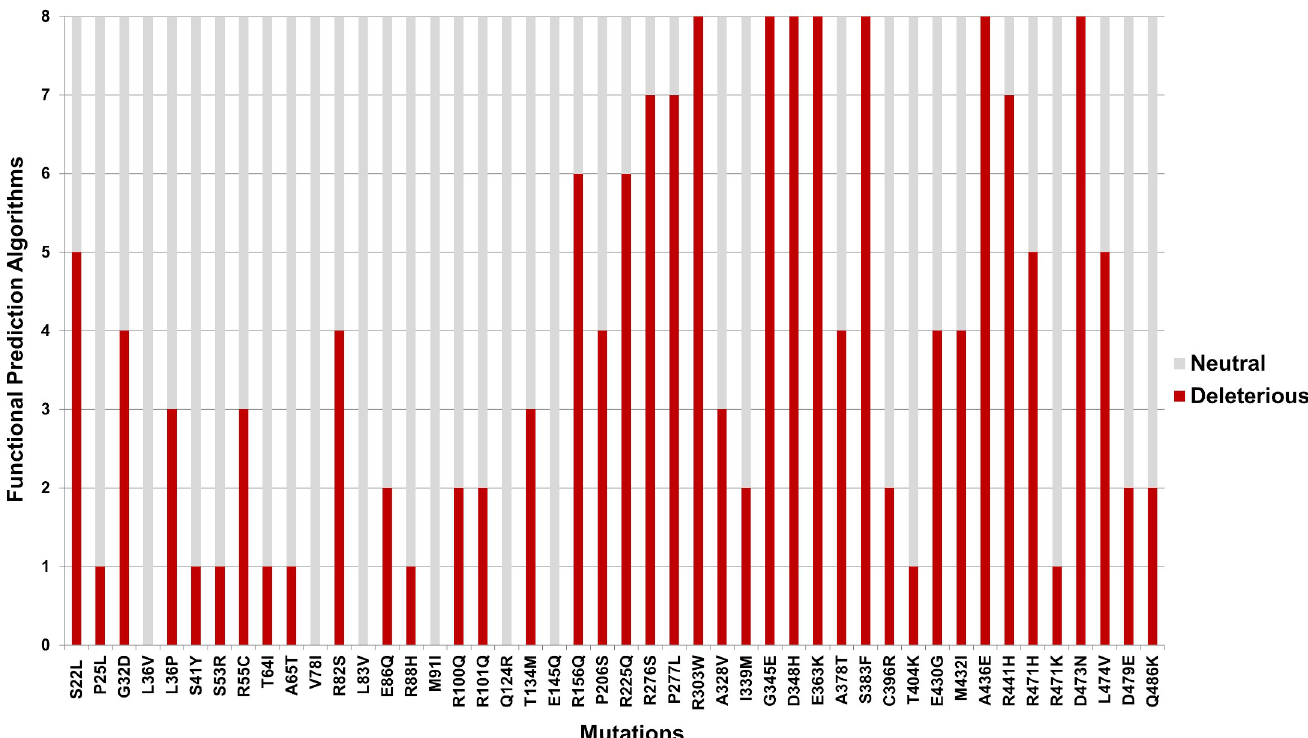
Fig 2. Functional prediction of TPH2 mutations. The 46 known TPH2 mutations were analyzed using eight different functional prediction algorithms. The bar plot indicates the number of neutral (gray bars) and deleterious (red bars) predictions for each TPH2 mutation.